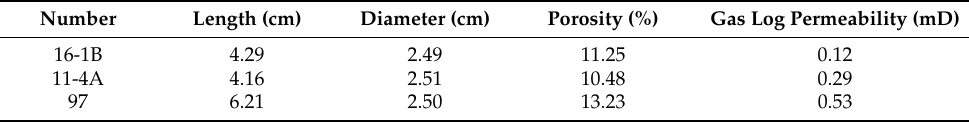
Table 1. Parameters of the three